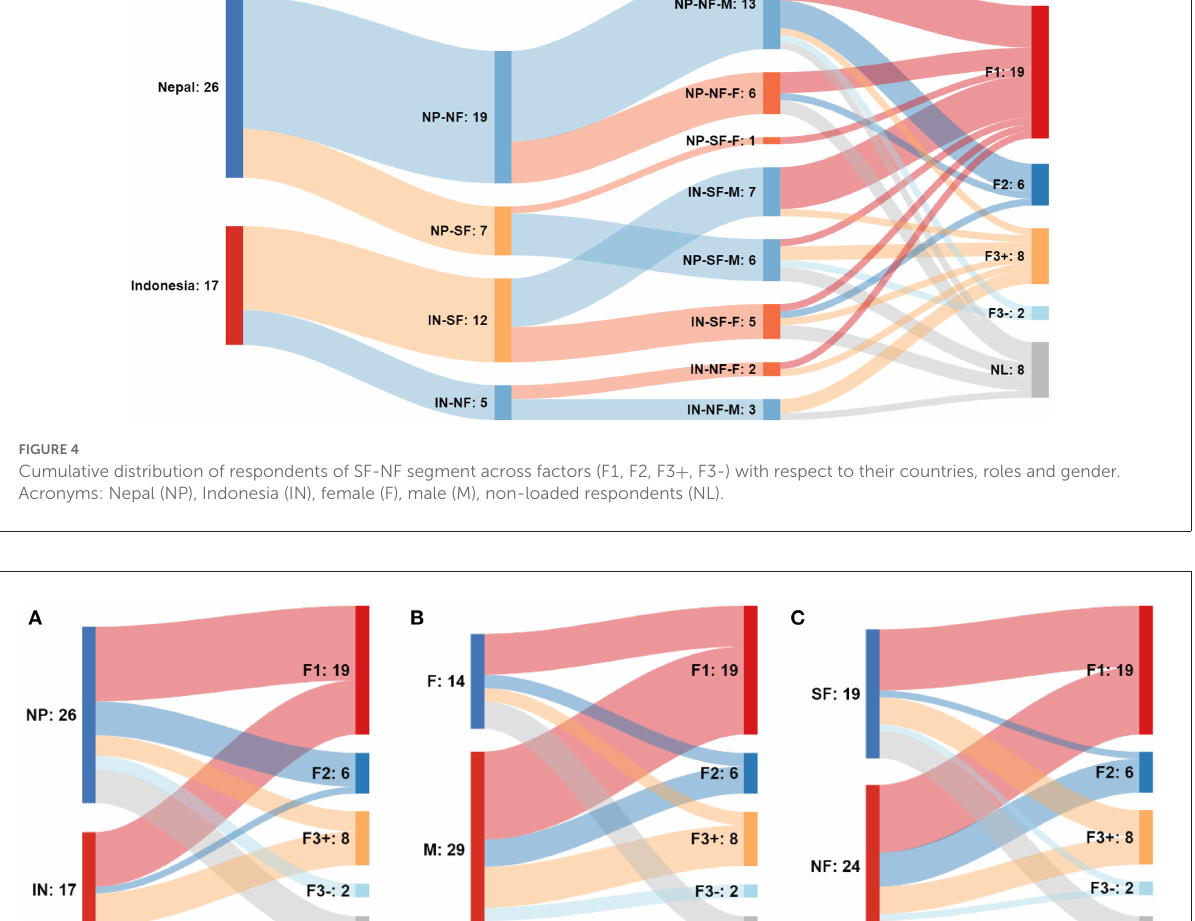
, F3-) regarding (A) country, (B) gender, (C) role. +